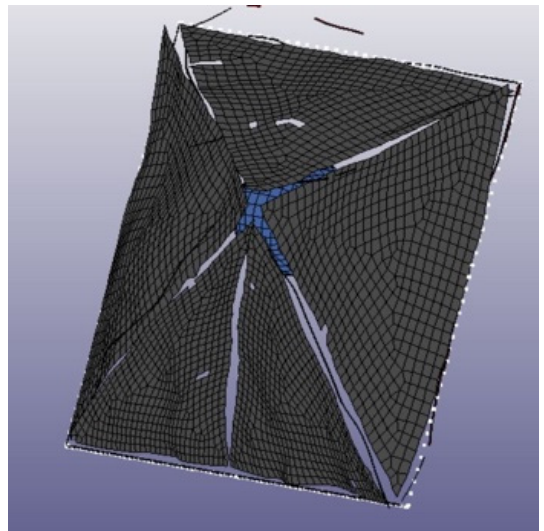
Figure 18. Pyramidal Multifaced VS Pavilion Dome Tailgate: Stress evaluation.